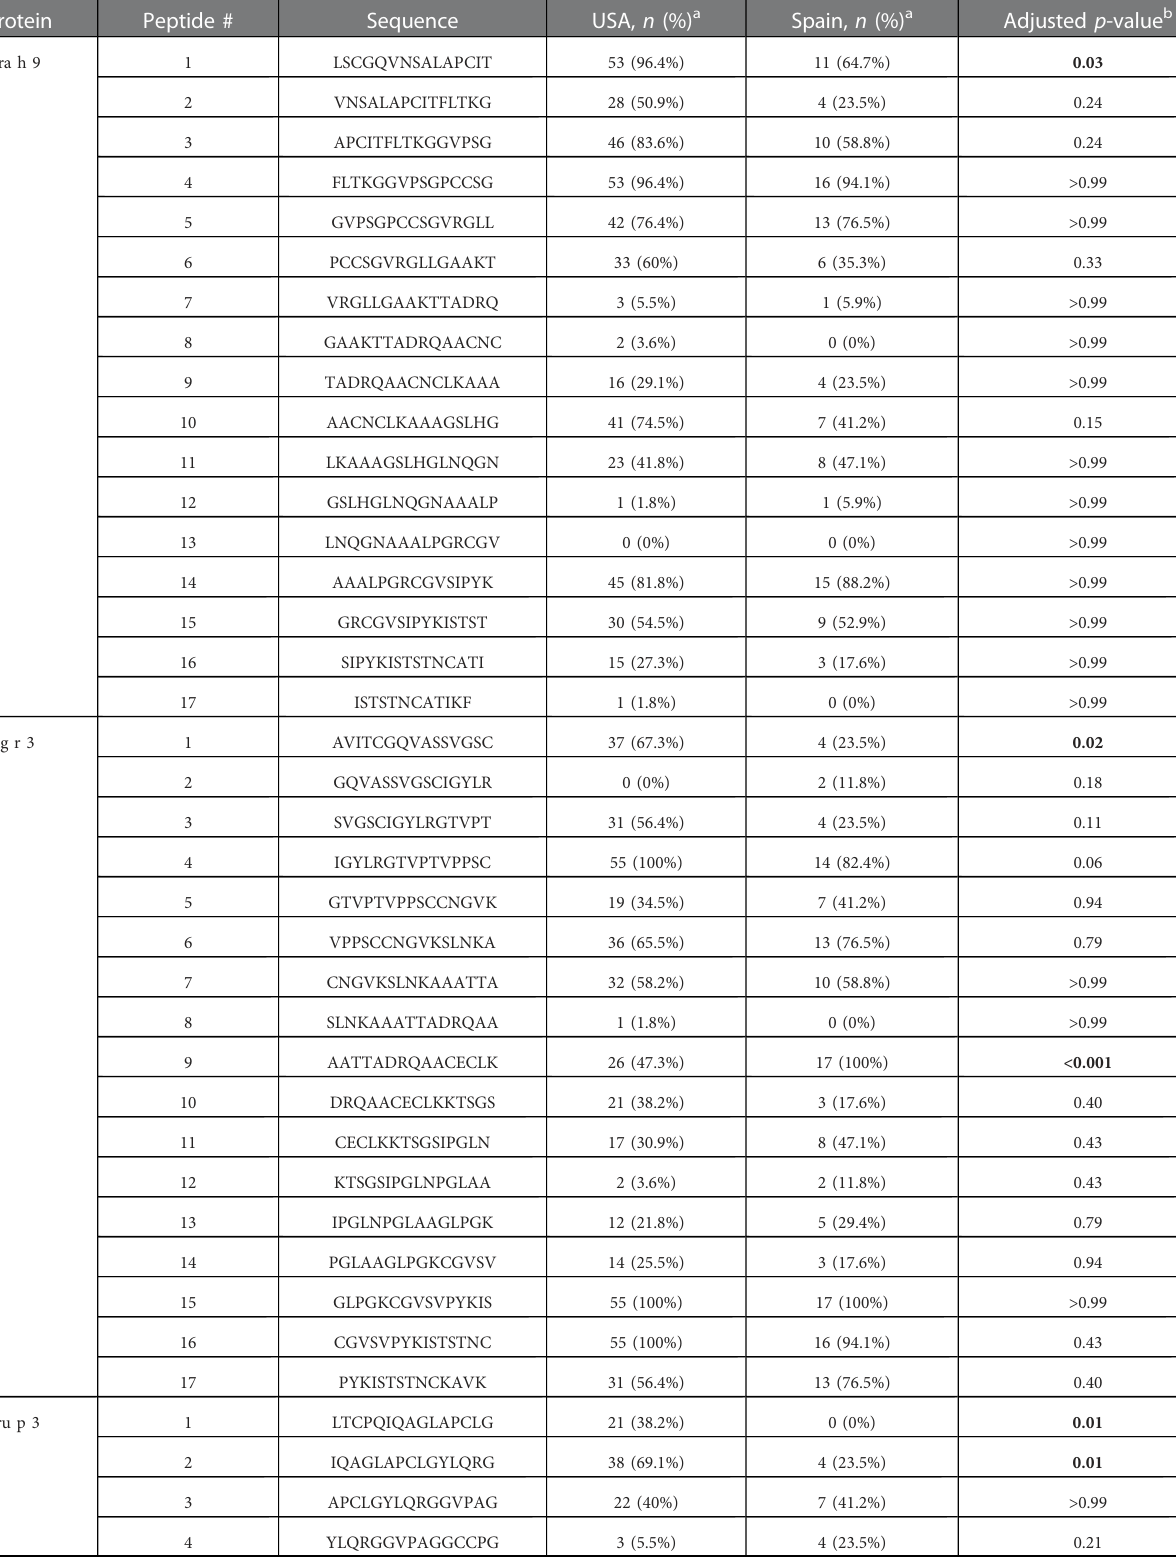
TABLE 5 Proportion of subjects with positive IgE binding to LTPs by peptide and region.